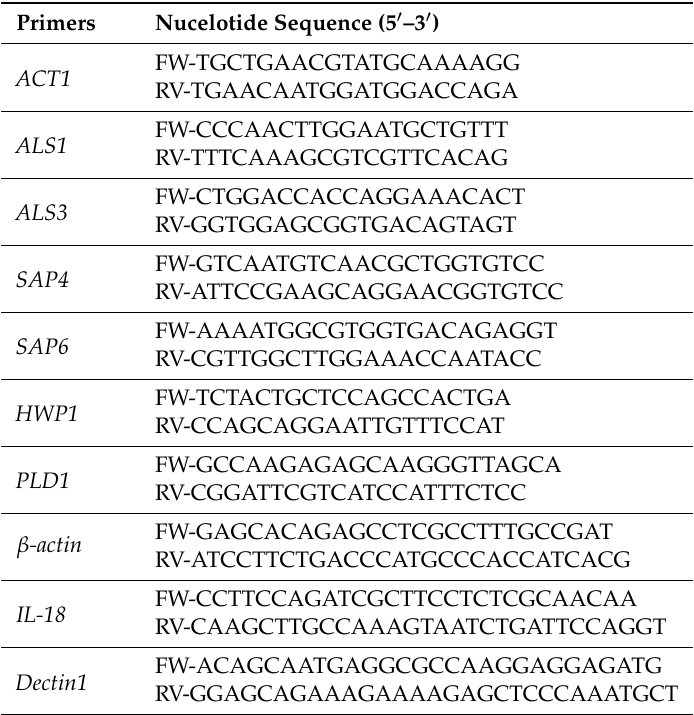
Table D1. Primers used in Real-time PCR [31]. FW: forward; RV: